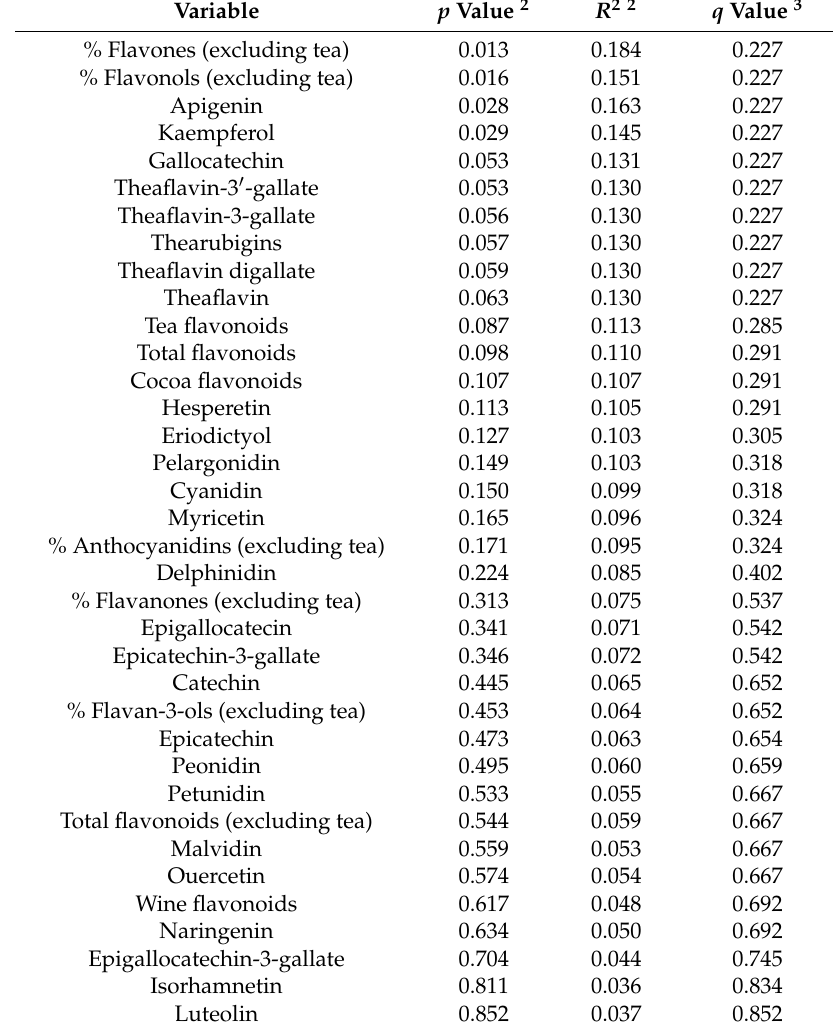
Table 2. Associations between flavonoid intakes 1 and gut microbiome based on weighted UniFrac